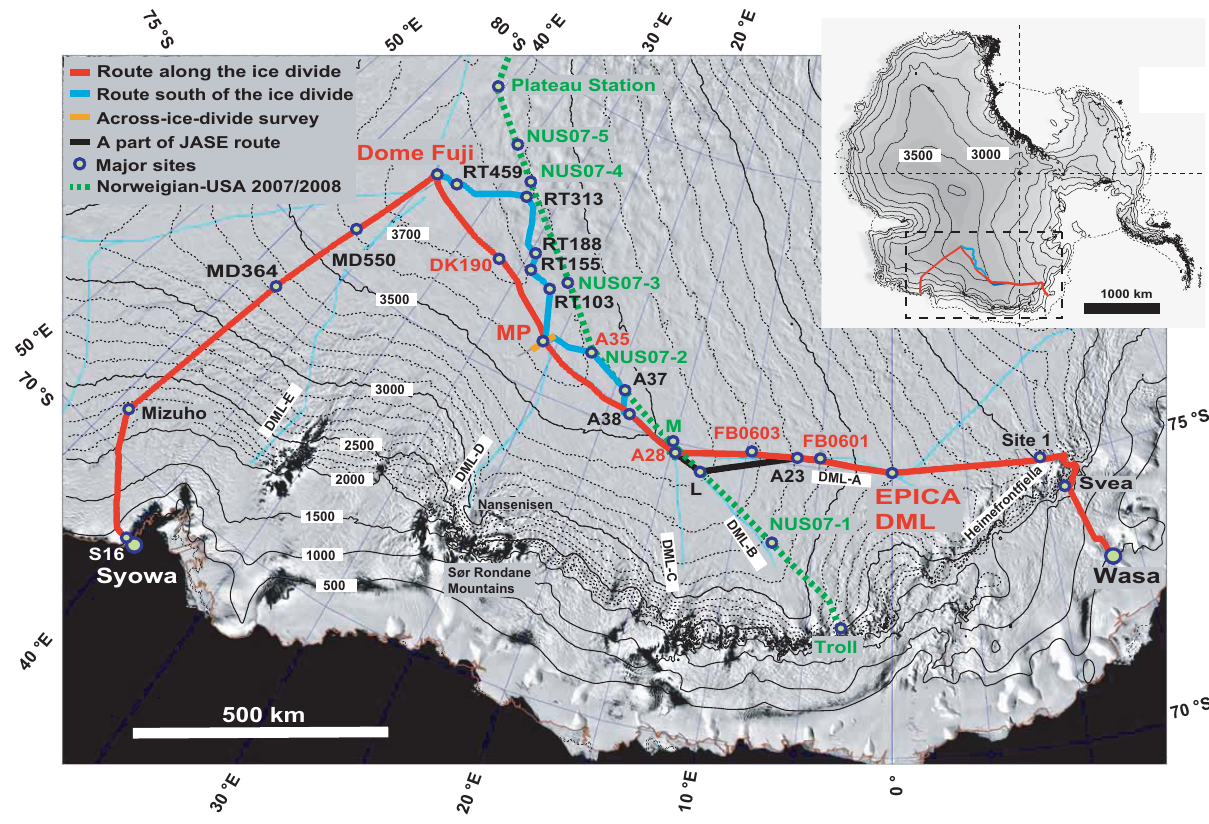
Fig. 1. Routes of the JASE traverse shown on a map of Antarctica. Surface elevation contour lines have a spacing of 500m below 2000m and of 100m above 2000m. The underlying satellite image is the MODIS mosaic of Antarctica (Haran et al., 2005). The red trace shows the route between S16 and Wasa. The blue trace shows the south routes (see text). Major sites are indicated by circular symbols (see also Table 1). Sites for pit studies and firn core studies are indicated by red letters. The orange line at MP is the trace of the cross-ice divide survey (see text). The black thick trace is also a part of the JASE traverse. The green dotted trace is the route of the Norwegian-USA traverse in the same 2007/2008 season (Ansch¨utz et al., 2011). Site names related to it are indicated with green letters. Light blue thin traces indicate ice divides on the ice sheet surface. For convenience, we labelled the ice divides DML-A to